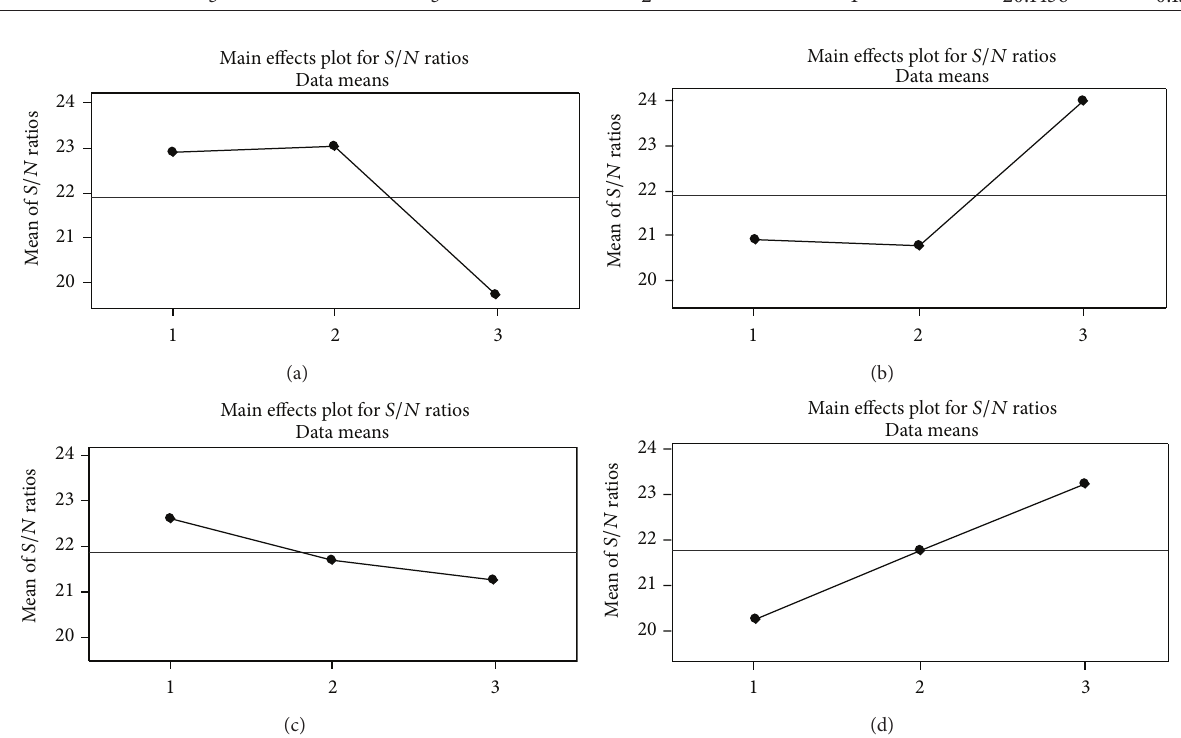
Figure 3: Main effect plots for 𝑆/𝑁 ratios. Signal-to-noise: nominal-the-best ( 10 ⋅ log 10 (𝑦 2 /𝑠 2 ) ).